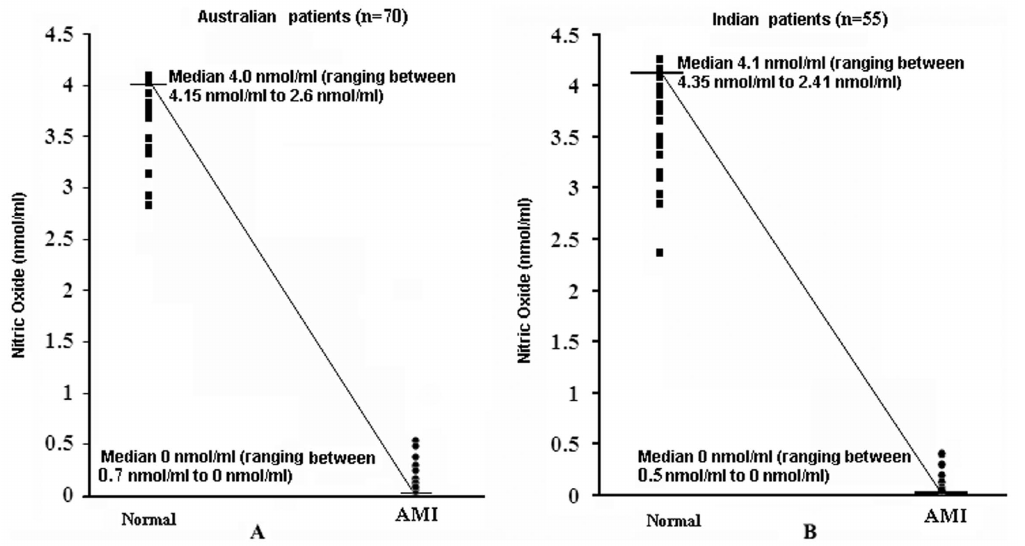
Figure 2. Nitric oxide levels in AMI patients in South Asia and in Southern Australia. The NO level was determined by methemoglobin method as described in the Materials and Methods section in both the cases. Panel A represents the median values of plasma NO level in AMI patients and in the equal number of age and gender matched normal volunteers in Australia. Panel B shows the median values of plasma NO level in AMI patients and in the age and gender matched normal volunteers in India.